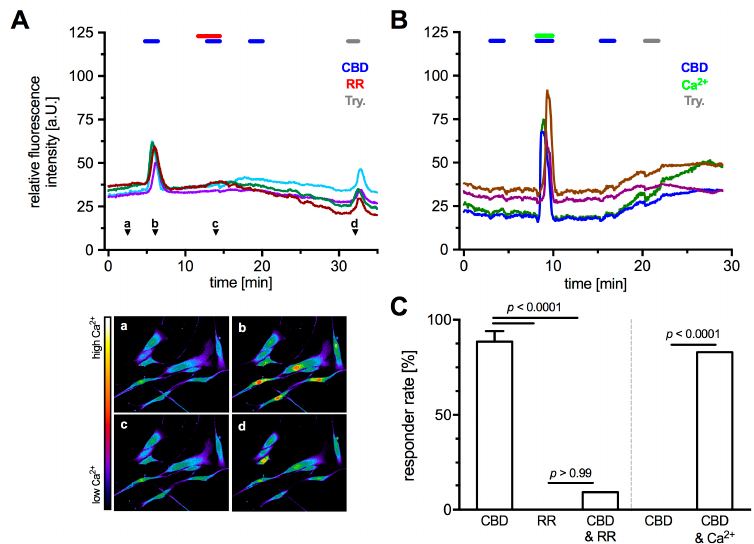
Figure 3. TRPV2 functionality as a Ca 2+ -channel in HTPCs was studied by applying the agonist CBD and the unspecific antagonists RR, in presence of CB1 and 2 blockers (AM251 and AM630), during Ca 2+ imaging. ( A ) Application of TRPV2 activator CBD (10 µM) in presence of 1 mM extracellular Ca 2+ led to a transient increase in intracellular Ca 2+ that could be blocked completely by RR (10 µM). ( a – d ) Relative Ca 2+ concentrations at the indicated time points ( A , arrow heads) as pseudo color images (red = high Ca 2+ ; purple = low Ca 2+ ). ( B ) In absence of extracellular Ca 2+ (0 mM), CBD alone did not induce any transients, whereas the combined application with Ca 2+ (1 mM) resulted in Ca 2+ transients, most likely due to Ca 2+ influx. Each graph shows original traces of four representative cells from different donors (in total 5). In all experiments, trypsine (1‰) served as positive control. ( C ) The total rate of responding cells upon CBD application was 88.6 ± 5.5% (121 cells from 5 donors). No reaction occurred upon RR application (0%), but combined application with CBD led to transients in 9.1% of the analyzed cells (11 cells from 2 donors). In absence of any extracellular Ca 2+ , cells did not show reactions to CBD application (0%), whereas combined application with extracellular Ca 2+ (1 mM) led to a responder rate of 83% (11 cells from 2 donors). The data were analyzed using Fisher’s exact test.